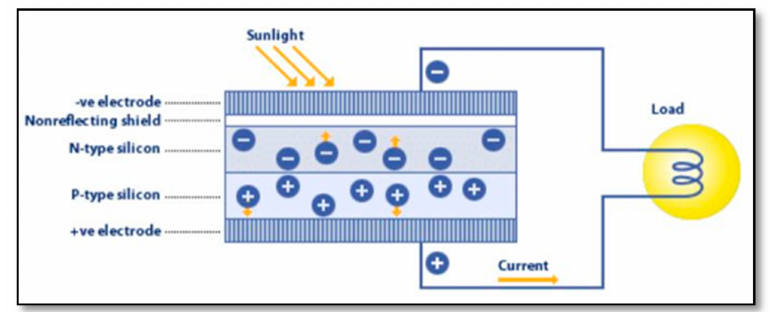
Figure 4. Conversion of sunlight into electricity